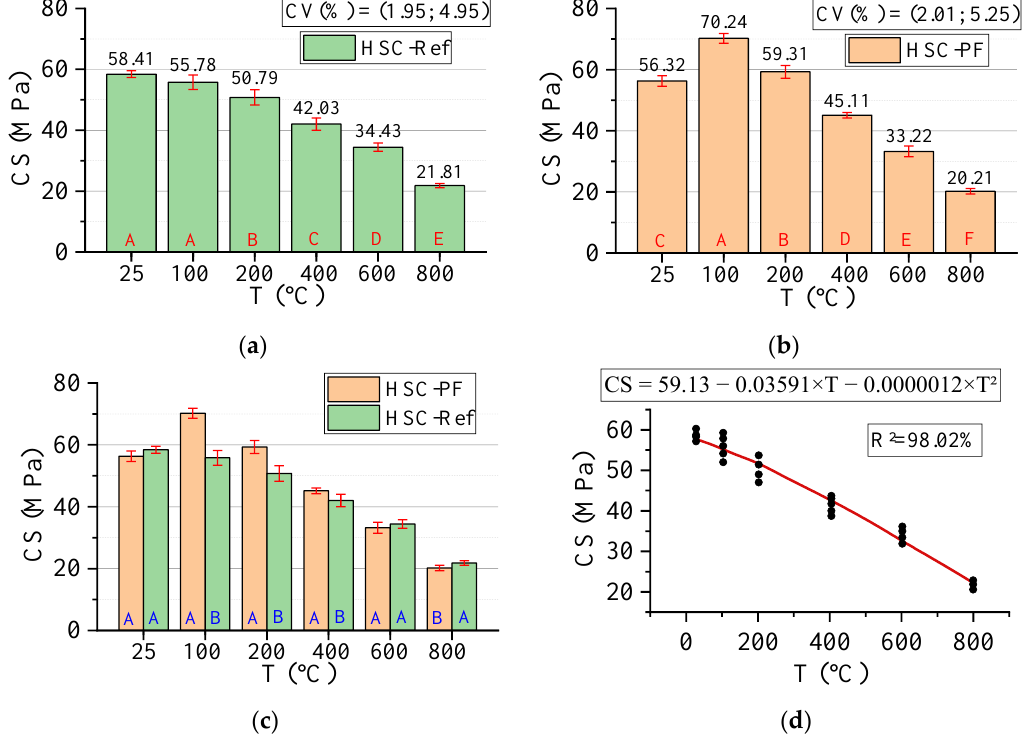
Figure 6. Compressive strength (CS) results summary: ( a ) Tukey’s test for the samples without polypropylene fibers, ( b ) Tukey’s test for the samples with polypropylene fibers, ( c ) Tukey’s test for the samples without and with polypropylene fibers and ( d ) Quadratic regression model fit to the experimental data set considering only the effect of temperature as an independent factor. The uppercase letters A – F in figure mean equivalence between the sample results.